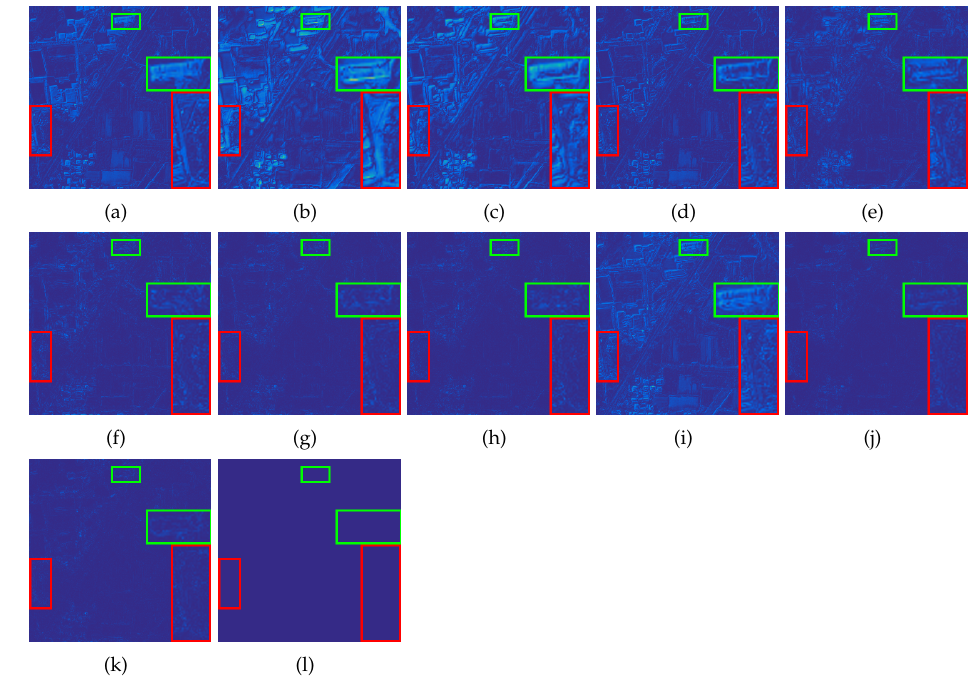
Figure 7. The residual images between the pansharpened results and reference images in Figure 6.